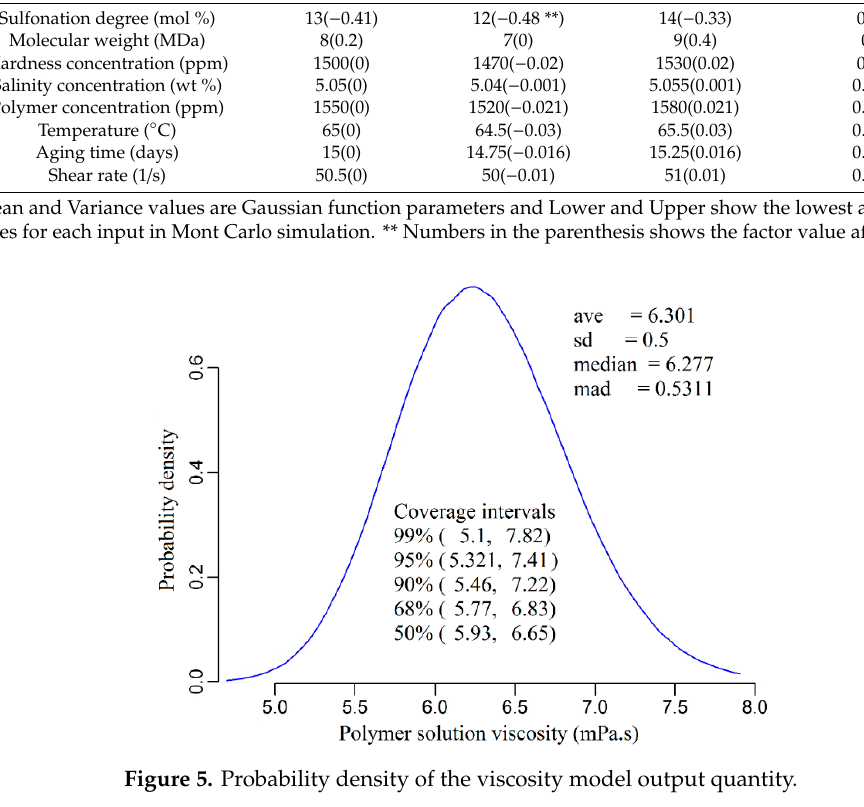
Table 5. Values of the input parameter and associated uncertainties derived from measurements number 28 from Table S1 in Supplementary File A.